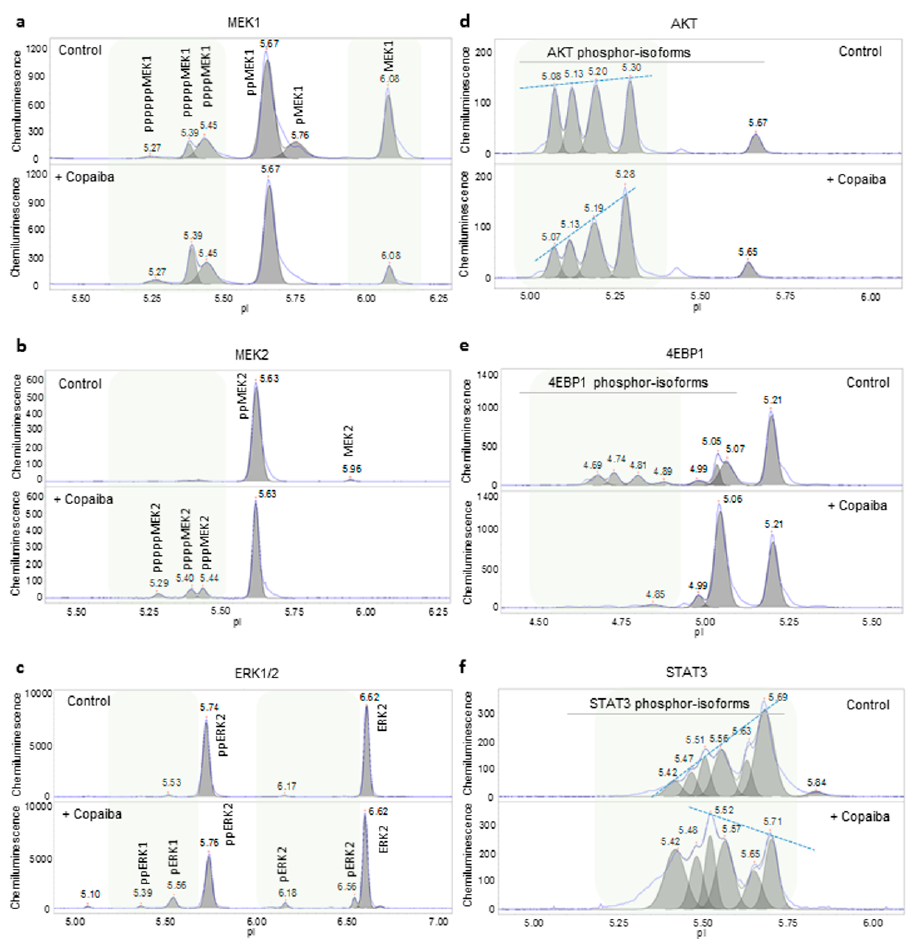
Figure 2. Biological e ff ects of copaiba essential oil on cellular signaling pathways. Copaiba essential oil positively regulated the MAPK signaling pathway by increasing MEK1 phosphorylation ( a ), MEK2 phosphorylation ( b ), and ERK1/2 phosphorylation ( c ). Copaiba essential oil negatively regulated the pI3K/Akt/mTOR signaling pathway by decreasing the levels of phosphorylated Akt ( d ) and 4EBP1 ( e ). Copaiba essential oil positively regulated the JAK/STAT signaling pathway by increasing the level of phosphorylated STAT3 ( f ). Shaded backgrounds highlight areas where substantial changes in the levels of protein isoforms were observed. Dashed lines connect peak intensities to highlight changes in the levels of the phosphorylated Akt and STAT3 isoforms following the treatment of HepG2 cells with copaiba essential oil. CD1 was used for these assessments. Table 1. Regulation of cellular signaling pathways by essential oils and their principle components.